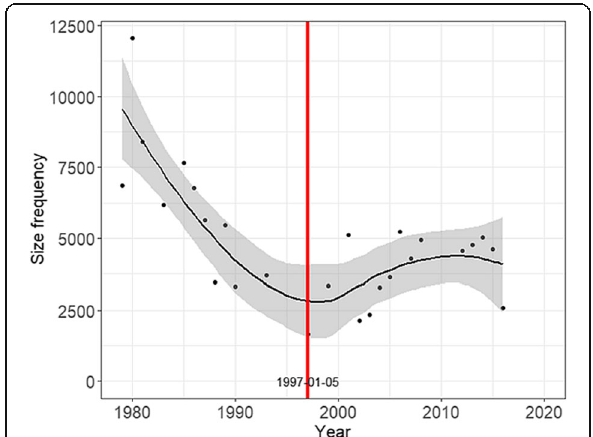
Fig. 6 Changes in size frequency of woody plants showing the change point in 1997